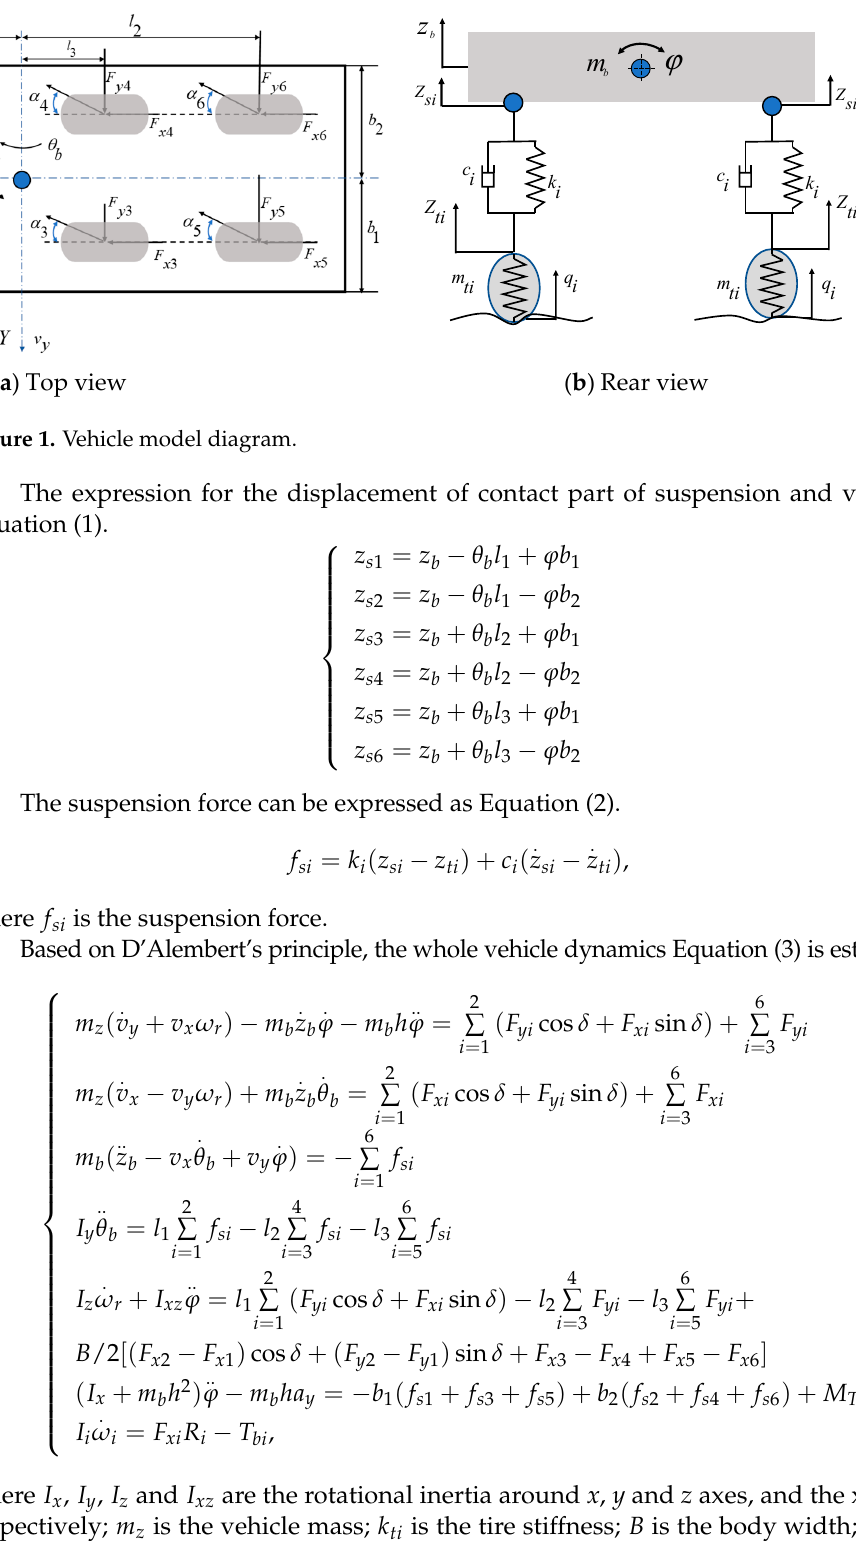
front, left center, right center, left rear and right rear, respectively. Right-center, left-rear and right-rear are the same below. z si , q i and α i are the suspension displacement, the input of road unevenness and the tire’s lateral deflection angle, respectively; c i , k i and f ai are the suspension stiffness, damping and active suspension force, respectively; δ is the front-wheel rotation angle; h is the center of mass height.